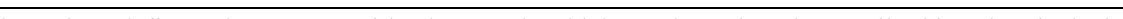
Fig. 6 Behavioral effects and consequences of dFB sleep vs. Gaboxadol sleep. a Flies in glass tubes were fi lmed from above for the duration of the experiment. DART software was used to track fl y activity and test behavioral responsiveness using a mechanical vibration. Red LEDs were used for optogenetic activation (see Methods section). b Behavioral responsiveness either probing for general responsiveness or arousal thresholds (top right panels) was tested by quantifying the change in fl y locomotor activity following the vibration stimulus (measured in g, see Methods section).